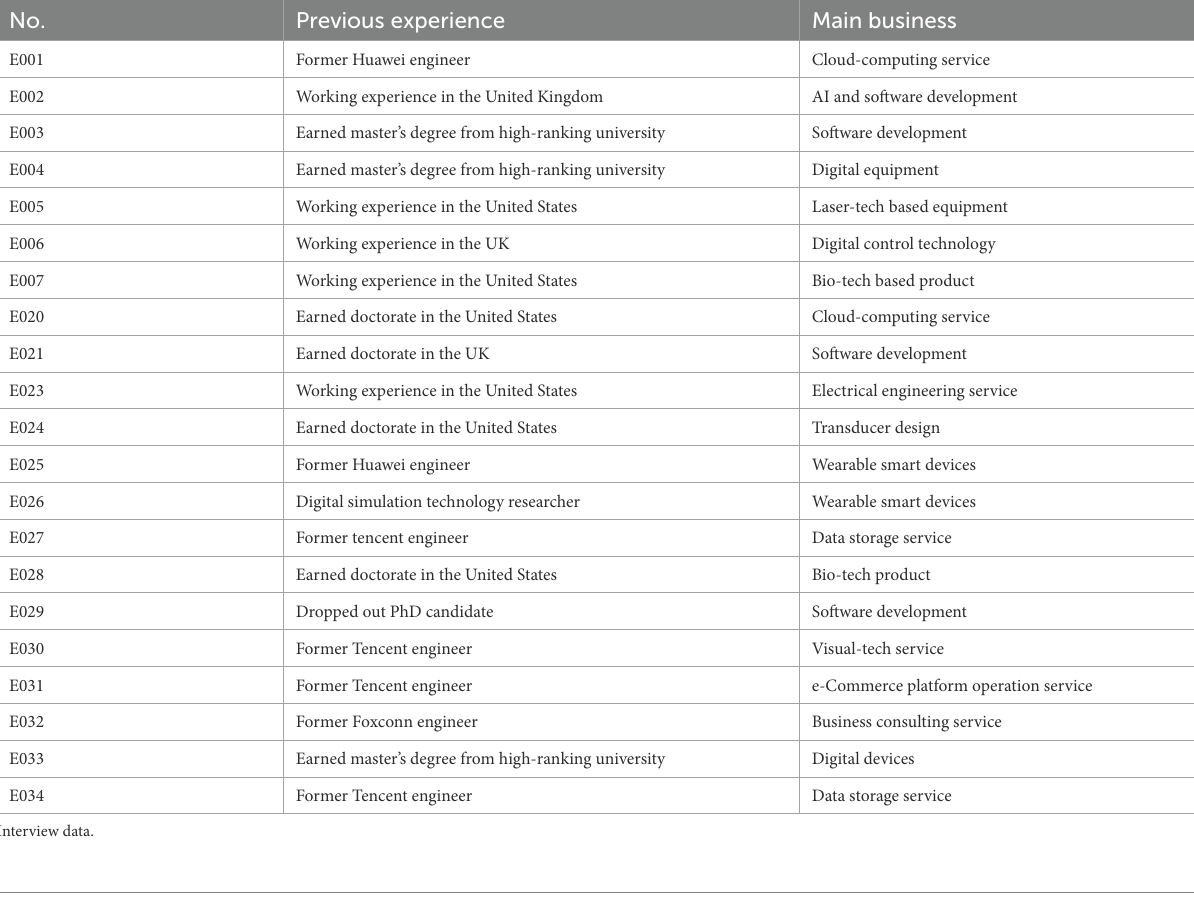
TABLE 4 Entrepreneurs who established enterprises between 2009 and 2018.